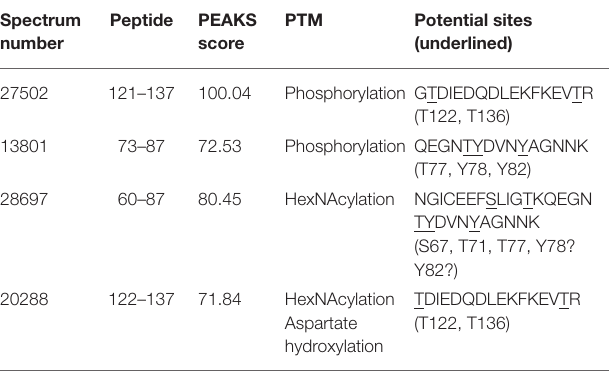
TABLE 2 | Identification of the peptides modified by phosphorylation and hexNAcylation: PEAKS analysis of PTMs in spot 11 from M14 sample. Spectrum